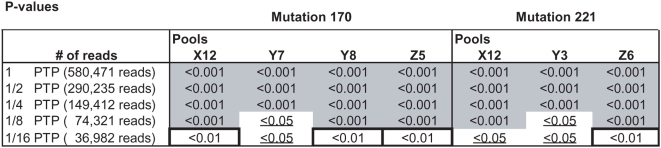
P-values of detecting mutations C170T and G221A in progressively smaller subsets of the total of 580,471 sequence reads obtained from a single GS FLX run.